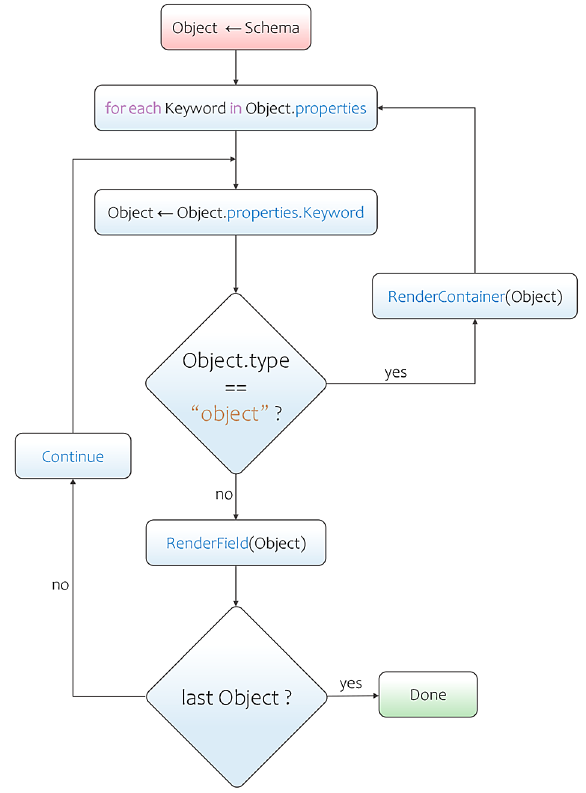
Figure 2. JSON schema to web-form rendering flowchart. JSON, JavaScript Object